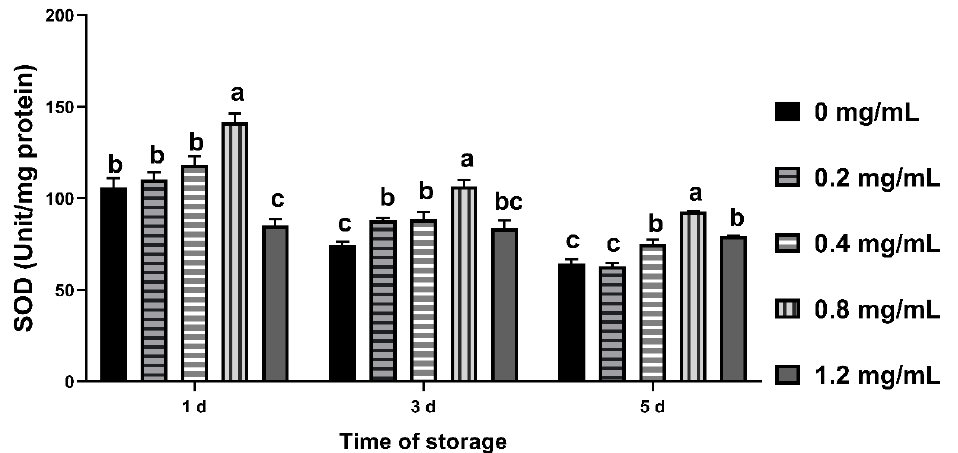
Figure 5. Effects of CGA with different concentrations on SOD activity of chilled ram sperm. Note: Different letters above the column indicate significant difference, the same or containing the same letter indicate insignificant